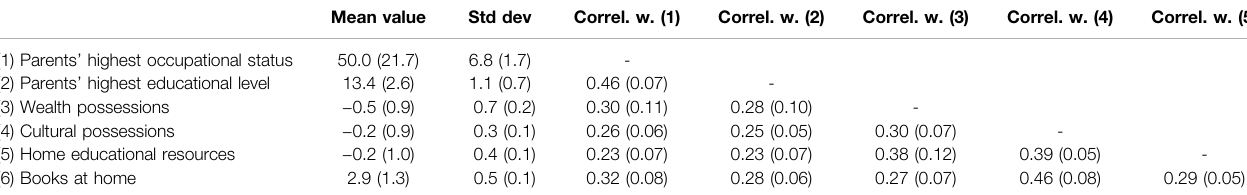
TABLE 1 | Mean (SD) within-society mean values, standard deviations, and Pearson intercorrelations among SES components in 77 societies.